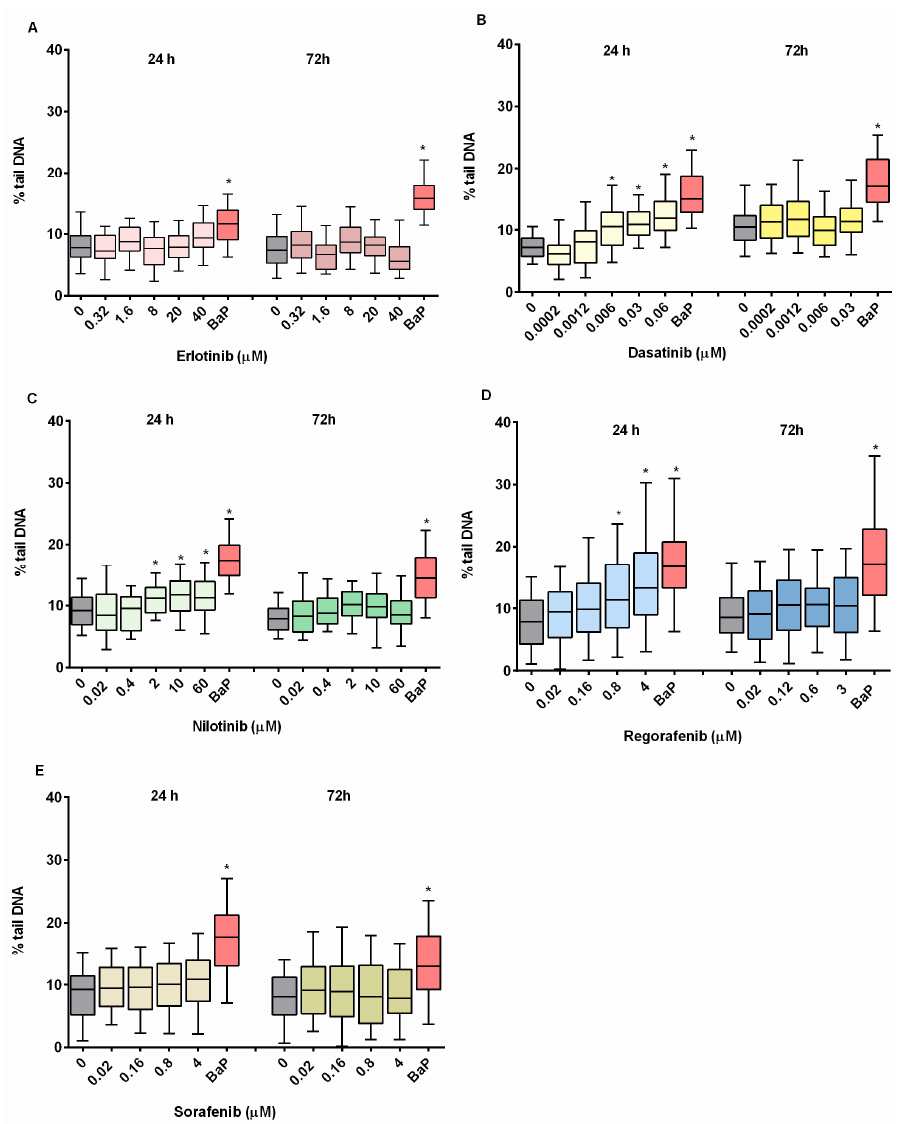
Figure 4. DNA damage evaluation in TKI-exposed ZFL cells. Cells were exposed to ( A ) erlotinib, ( B ) dasatinib, ( C ) nilotinib, ( D ) regorafenib, ( E ) sorafenib for 24 and 72 h. DNA damage was assessed by the comet assay and is expressed as percentage (%) of DNA in the comet tail. Fifty nuclei were measured per experimental point and are presented in box-plots. Three independent experiments were performed. B(a)P (benzo[a]pirene 50 μ M) was used as positive control. * ( p < 0.05).